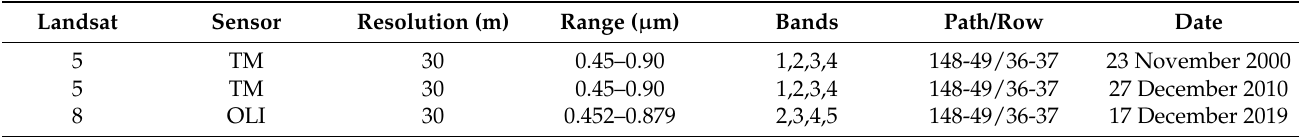
Table 1. Characteristics of the satellite images used.